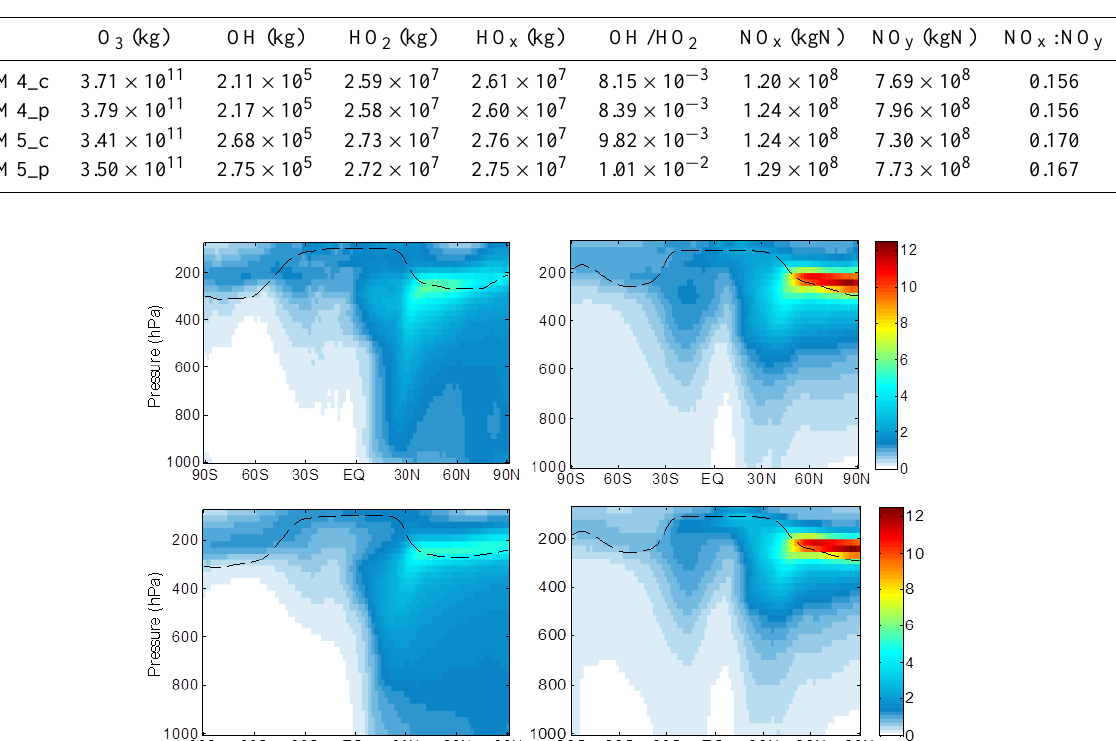
Figure 6. Zonal mean perturbations of ozone (ppb) during January (left) and July (right). CAM5 is in the top panel, while CAM4 is on the bottom. The dashed line indicates the